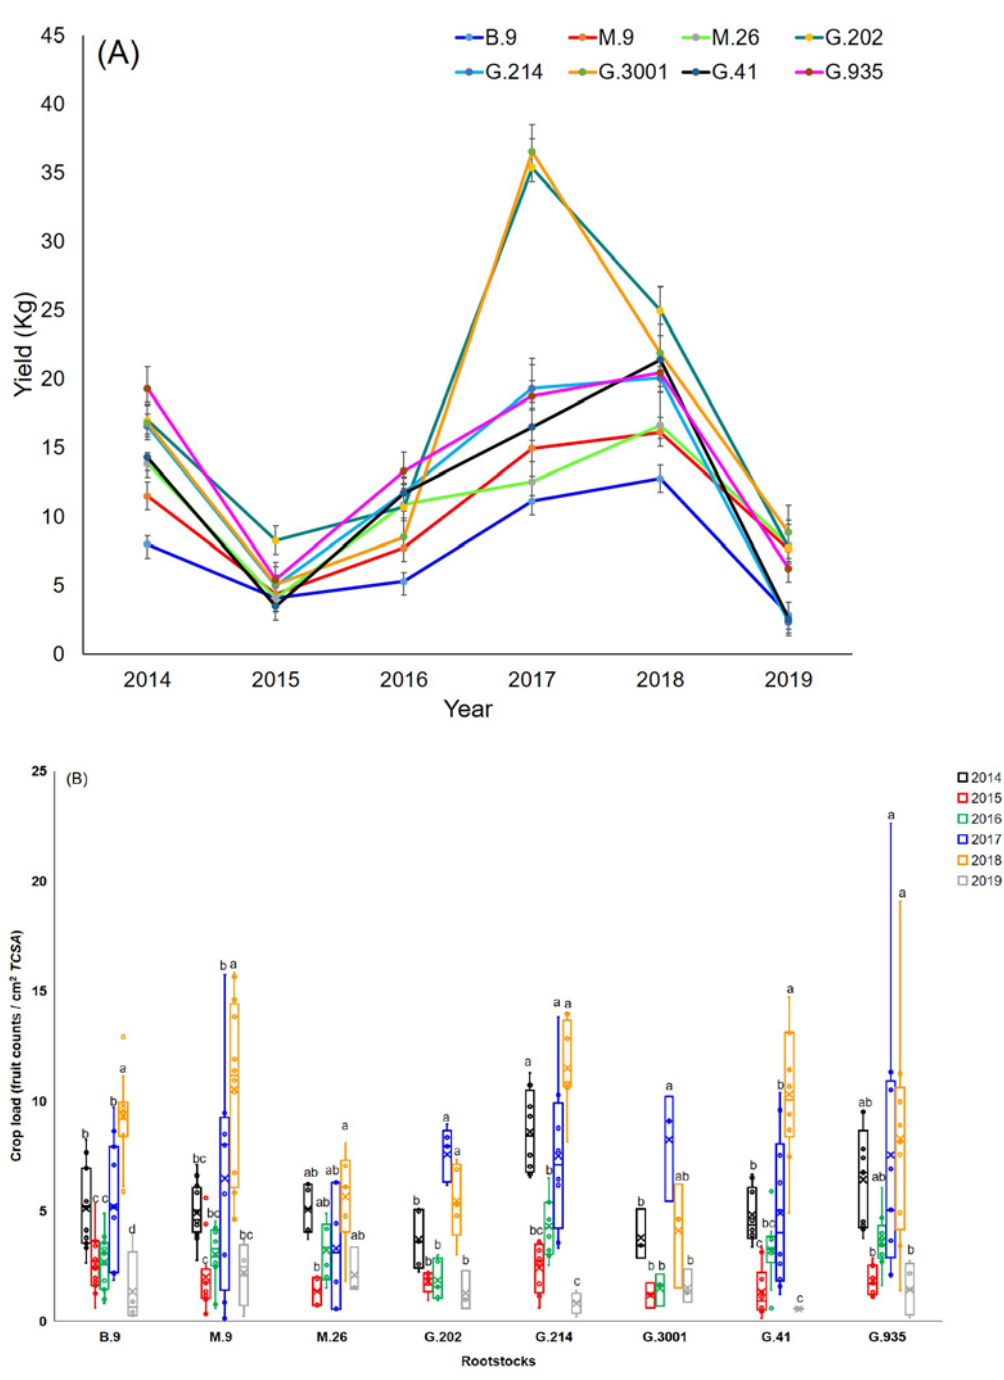
Figure 2. Annual variations in ( A ) yield and ( B ) crop load of Honeycrisp apple on eight rootstocks, from 2014 to 2019. For each rootstock, different letters indicate significant difference amongst the years ( p ≤ 0.05, ANOVA, Tukey–Kramer Pairwise Comparisons; n = 6 for M.26, n = 5 for G.202, n = 3 for G.3001, and n = 9 for other